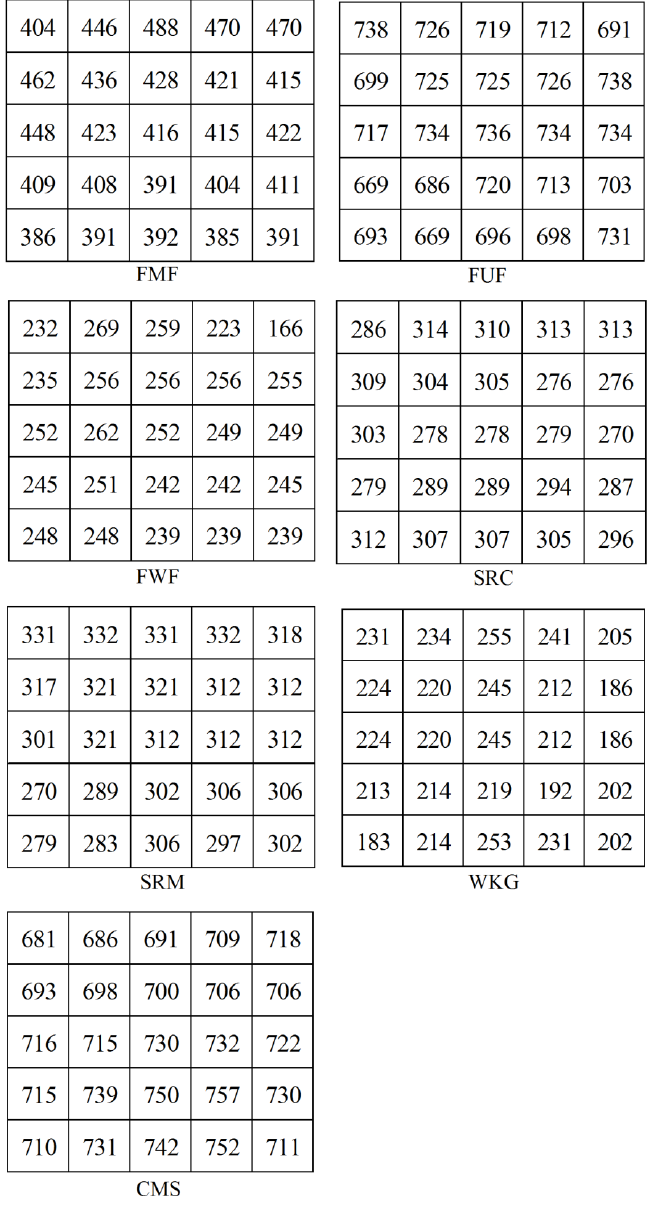
Figure 7. Annual evapotranspiration values for 5 × 5 Landsat pixels centered over the eddy covariance tower at the Flagstaff managed forest (FMF), Flagstaff unmanaged forest (FUF), Flagstaff wildfire (FWF), Santa Rita Creosote (SRC), Santa Rita Mesquite (SRM), Kendall Grassland (WKG), and Charleston Mesquite (CMS)